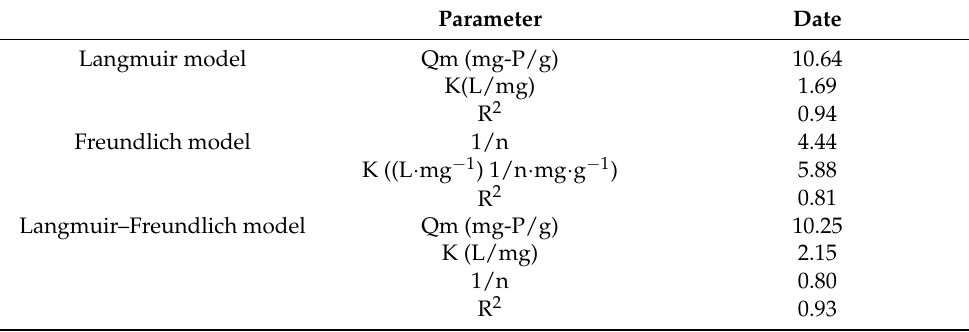
Table 4. Calculation parameters of isotherm model of phosphate adsorption.